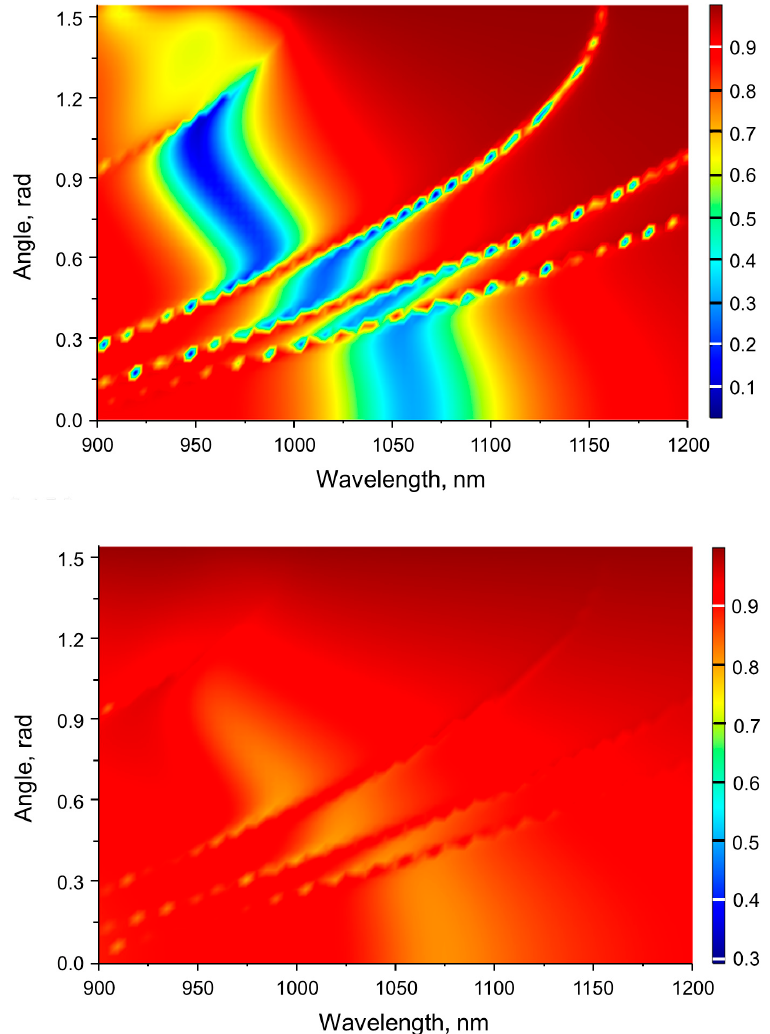
Figure 9. Full spectral dispersion of reflectance for TE polarization for the structure with an embedded diffraction grating coupler (shown in Figure 1b,c) when illuminated from the top ( top image ) and from the bottom ( bottom image ).